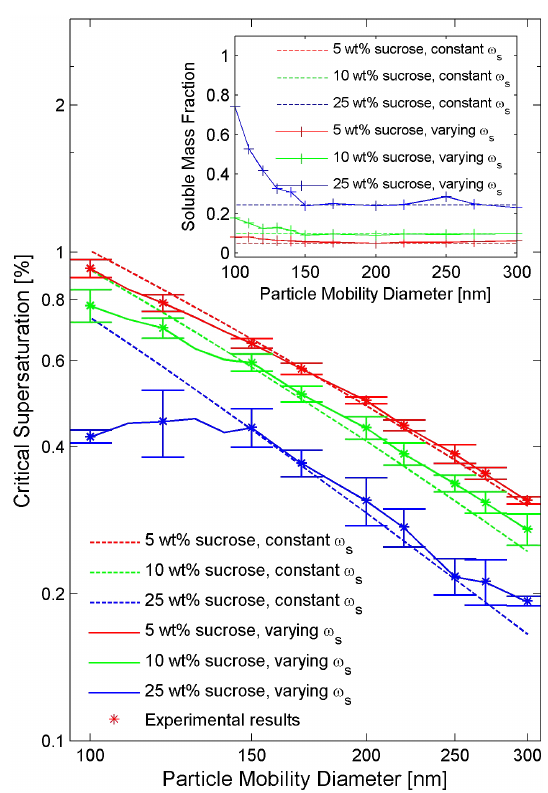
Figure 10. Experimental and theoretical critical supersaturations for mixed silica + sucrose particles for different particle mobility diameters using the model of Kumar et al. (2011b). Dashed lines represent calculated critical supersaturations based on an assump- tion of constant soluble mass fractions ( ω s ) with changing diam- eter and solid lines show the critical supersaturations based on the size-dependent soluble mass fractions. Error bars represent the min- imum vs. maximum values of supersaturation to estimate the s c cor- responding to each mobility diameter. The inset represents assumed constant soluble mass fractions as well as size-dependent ones cor- responding to the 50% points in the CCN/CN curves for different size vs. supersaturation pairs of mixed silica + sucrose